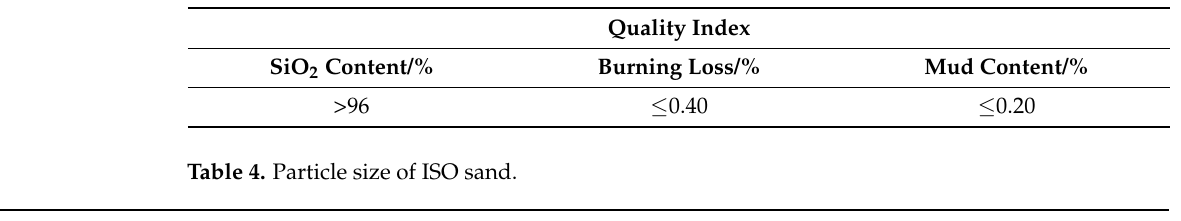
Table 3. Technical indicators of standard sand.